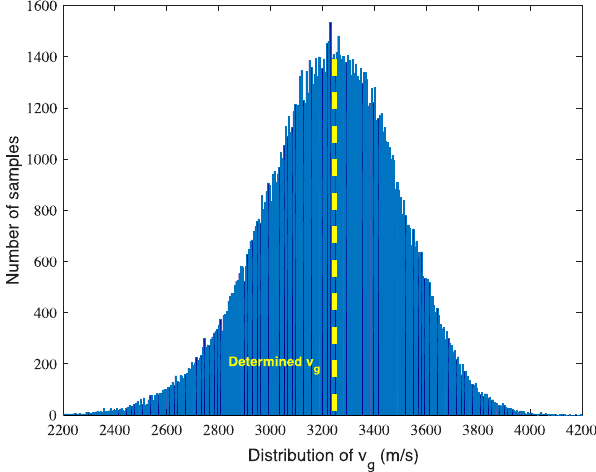
Figure 6. Group velocity determination based on the Monte Carlo simulation.